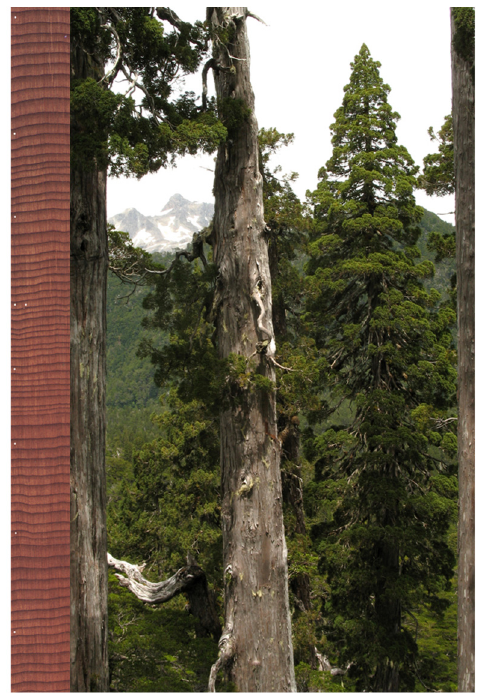
Figure 3. Old-growth forest of F. cupressoides with millennial individuals in the Andes of Northern Patagonia, Chile. At the left appears a F. cupressoides tree-ring sequence with its distinct annual rings growing from the bottom up. White dots are positioned every 10 years.